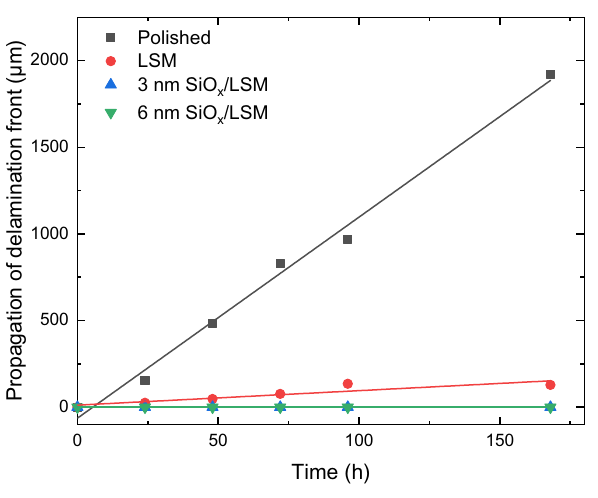
Fig. 10 Progress of the delamination front as a function of time for the different surface